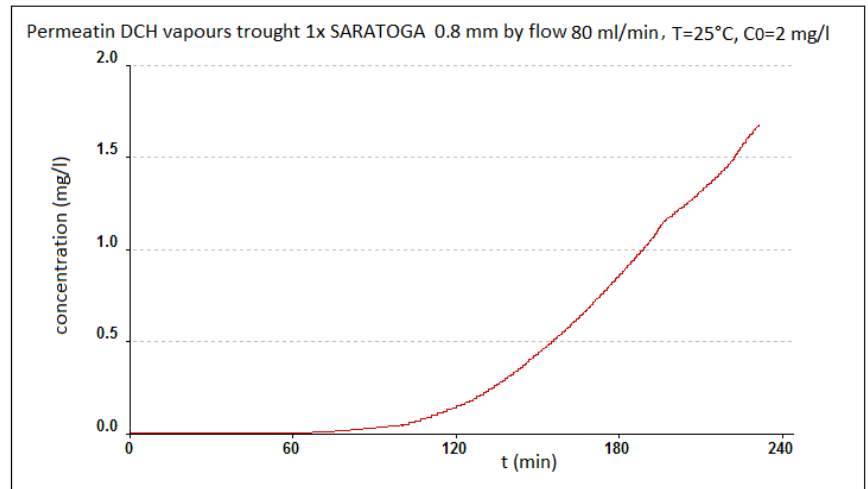
Figure 7. The appearance of individual layers of adsorptive textile SARATOGA Pyjama (covering the fabric, lining, and spherical Activated Carbon — SAC). An example of the permeation of 1,6-dichlorohexane (DCH) through this material under dynamic conditions at a flow rate of 10 mL/min/cm 2 , an inlet concentration of DCH 2 mg/L, a temperature of 30 °C, and a relative humidity of 35%.